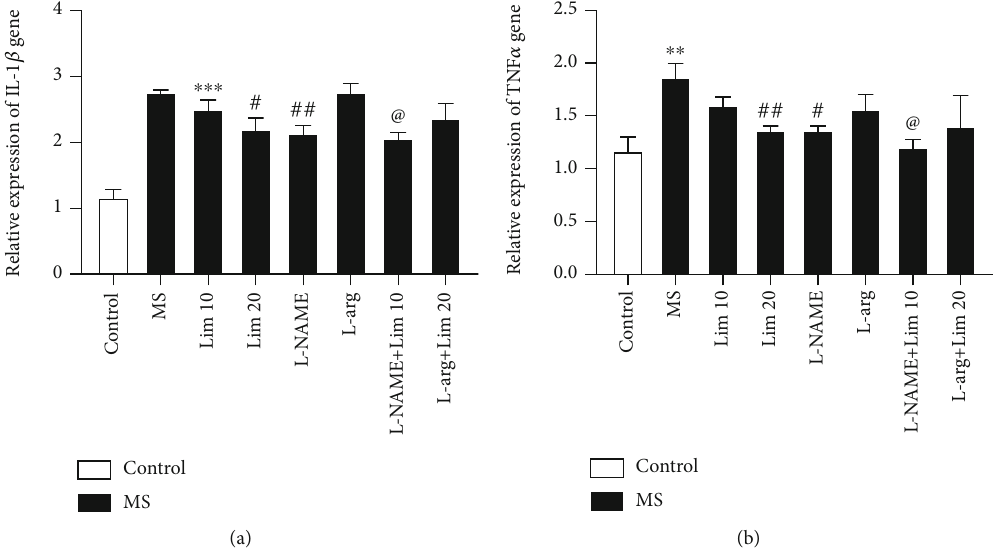
Figure 6: The expression of in fl ammatory genes in the hippocampus. (a) Il-1 β and (b) Tnf- α . Values are presented as the mean ± S : E : M : from 4 samples and were analyzed by one-way ANOVA followed by Tukey ’ s post hoc test. ∗∗ P < 0 : 01 and ∗∗∗ P < 0 : 001 compared to the control group. # P < 0 : 05 and ## P < 0 : 01 compared to the MS group. @ P < 0 : 05 compared to the group that received limonene (10 mg/kg). MS: maternal separation; Lim: limonene; L-arg: